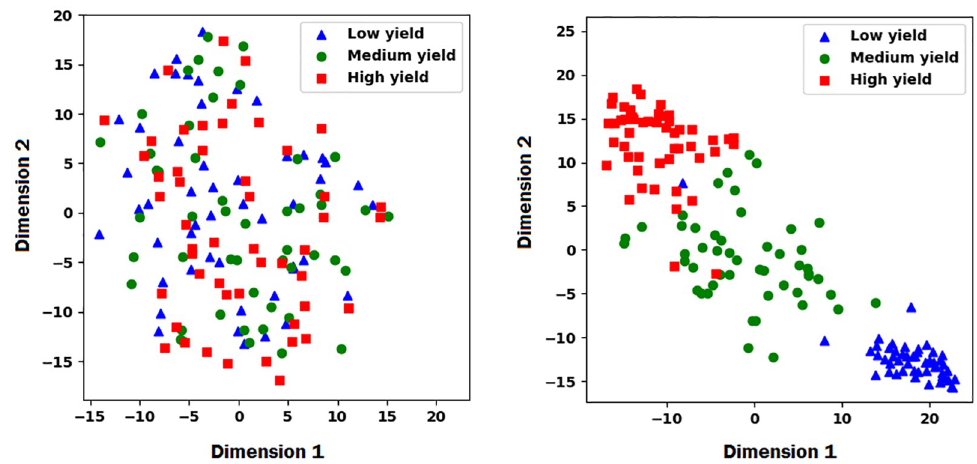
Fig 3. The left and right plots show the t-SNE embedded plot of testers latent factors before and after training, respectively. The plots illustrate how the proposed model was able to differentiate the high, medium, and low yield testers based on their corresponding latent factors in the embedding